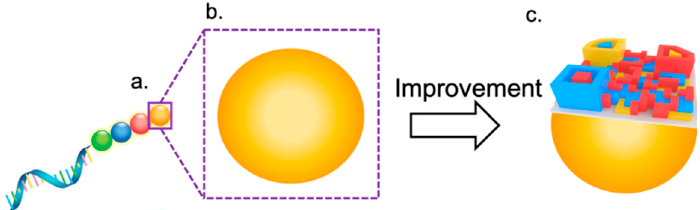
Figure 5. Schematic of future 3D identification code for biosensing with various and distinguished 3D patterns of colors, shapes, heights, and widths.